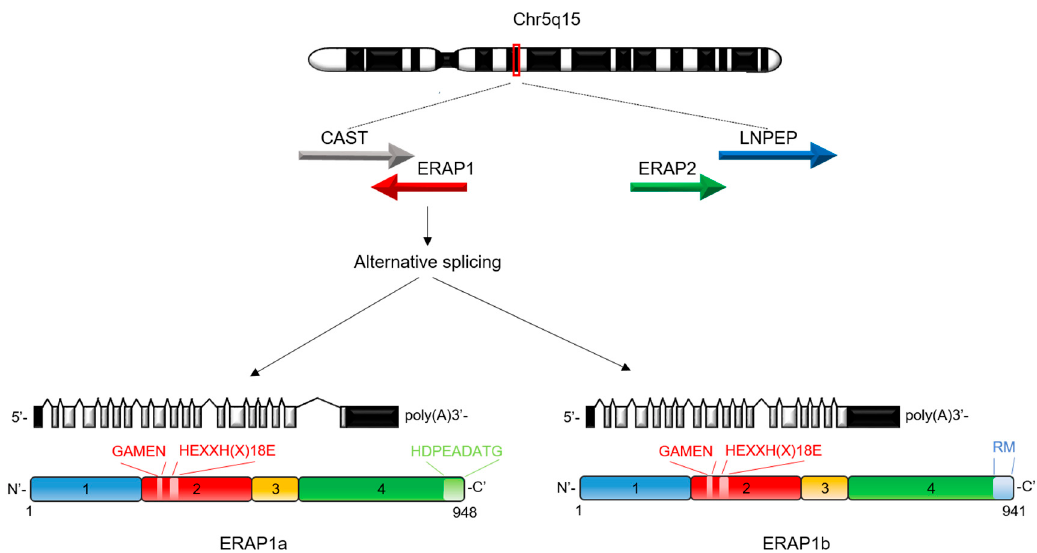
Figure 2. Genomic organization of the human endoplasmic reticulum aminopeptidase 1 ( ERAP1 ). Genomic organization of the human chromosome 5q15 containing the ERAP1 gene. Exons are depicted as boxes. Alternative splicing of the ERAP1 gene gives rise to two isoforms, ERAP1a and ERAP1b of 948 and 941 amino acids, respectively. The crystallographic structure of human ERAP1 contains four domains indicated with different colors. The GAMEN and HEXXHX (18) E motifs are highlighted in domain II. The amino acids that differentiate the two isoforms at 3’untranslated region (3 (cid:48) UTR) are